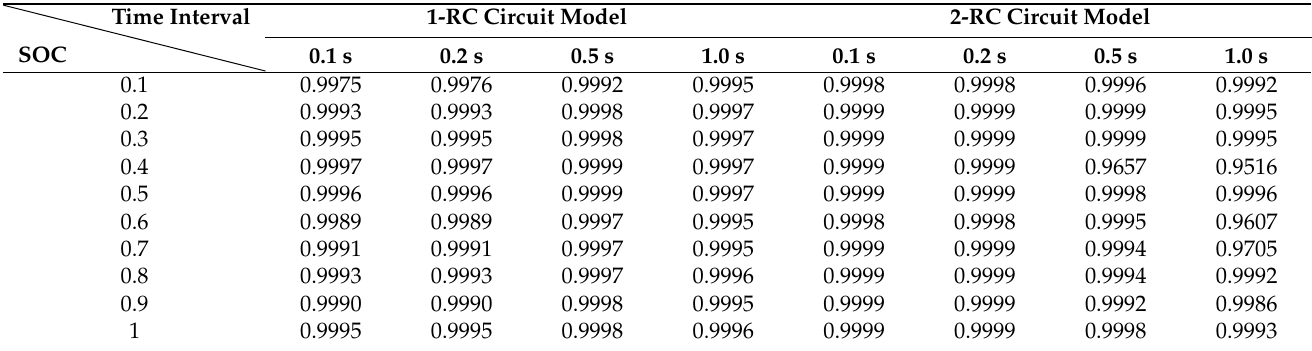
Table 2. Goodness of fit.